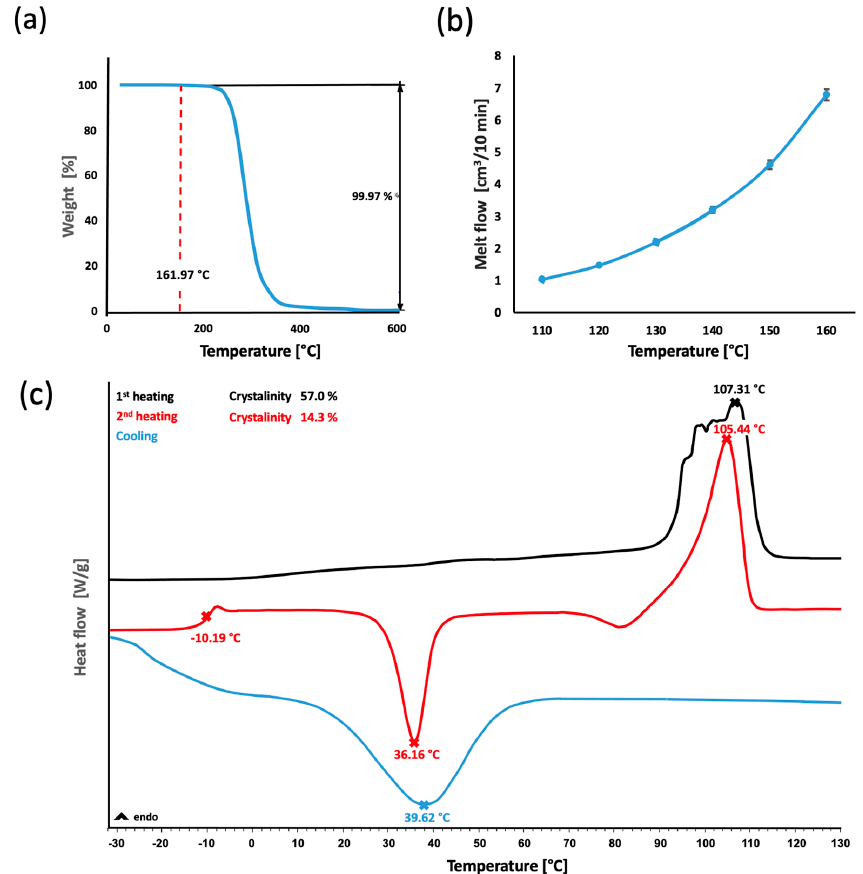
Figure 2. Thermal properties of the PDO granulate: TGA analysis of the thermal degradation − ( a ), MVR rheological measurement − ( b ) and DSC curves of the crystallinity and transition temperatures − ( c ).